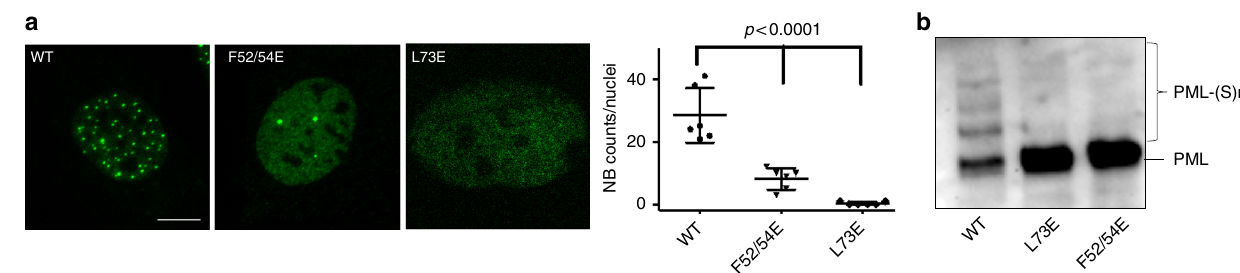
Fig. 4 PML tetramerization in NB assembly and PML sumoylation in cellulo. a Pml − / − MEFs stably expressing wild type HA-PML, HA-PML F52/54E and HA- PML L73E were analyzed by immuno- fl uorescence using anti-HA antibodies (left, green). Scale bar is 5 μ m. Statistical analyses (right). All experiments have been done in fi ve independent replicates, NB count was from 10 to 20 nuclei. Values are means ± S.D. and One-way ANOVA ( p -values) are indicated. b Western blot analysis demonstrating loss of sumoylation of these PML mutants, as detected by anti-HA antibodies. Uncropped images of all